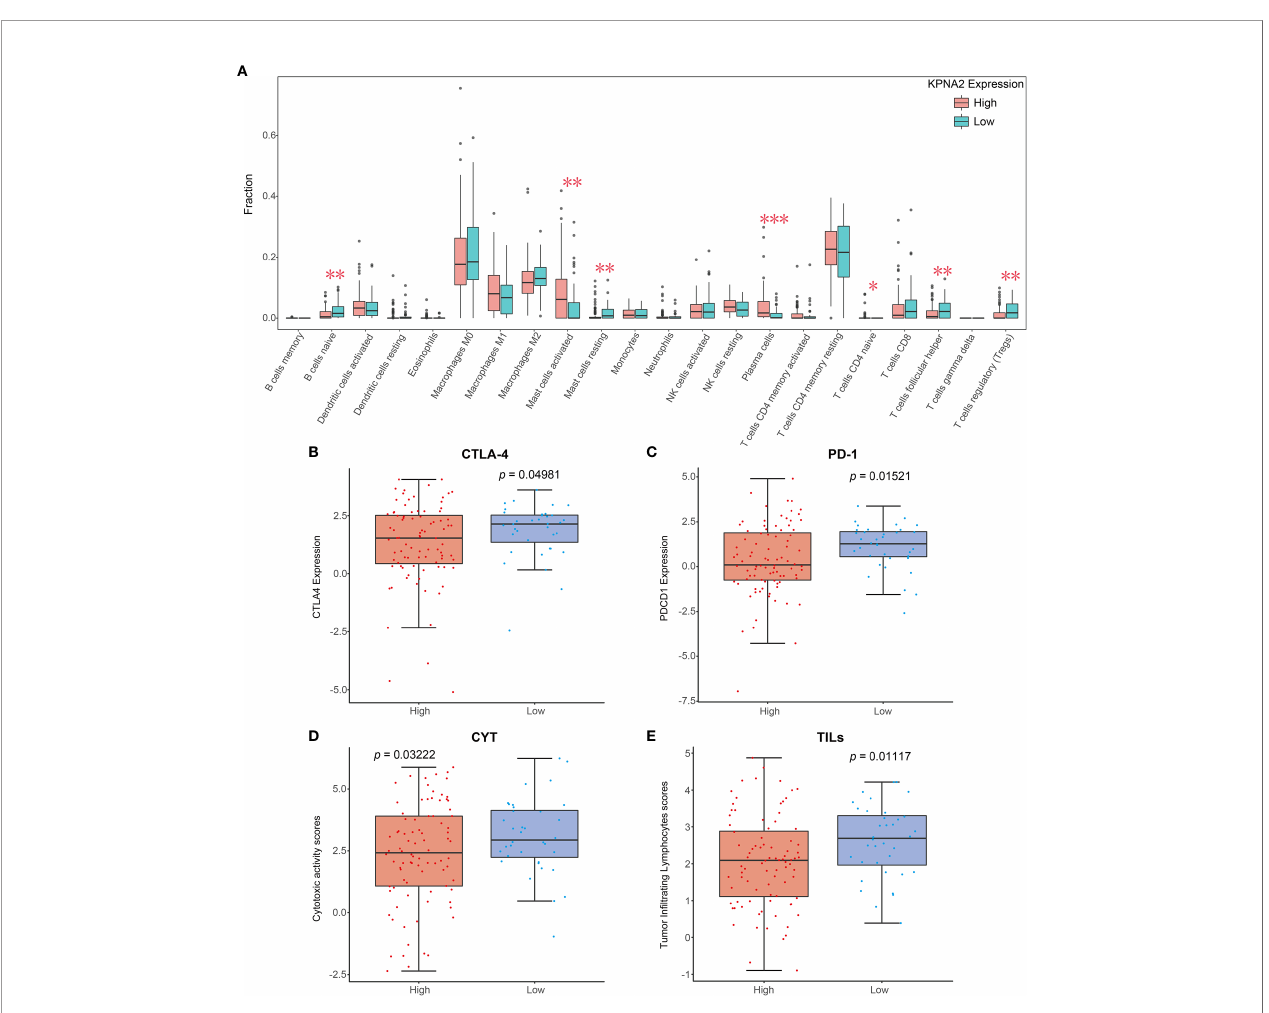
FIGURE 2 | Relationship between KPNA2 levels and tumor immune landscape of TSCC. (A) Relationship between KPNA2 level and the proportion of 22 TIICs in TSCC tissues. (B – E) Box plots show different immune checkpoints between KPNA2 low- and high-expression cases. PD-1 (PDCD1), programmed cell death 1; CYT, cytotoxic activity; TILs, tumor-in fi ltrating lymphocytes; CTLA-4, cytotoxic T-lymphocyte associated protein 4. *P < 0.05, **P < 0.01 or ***P < 0.001, relative to High